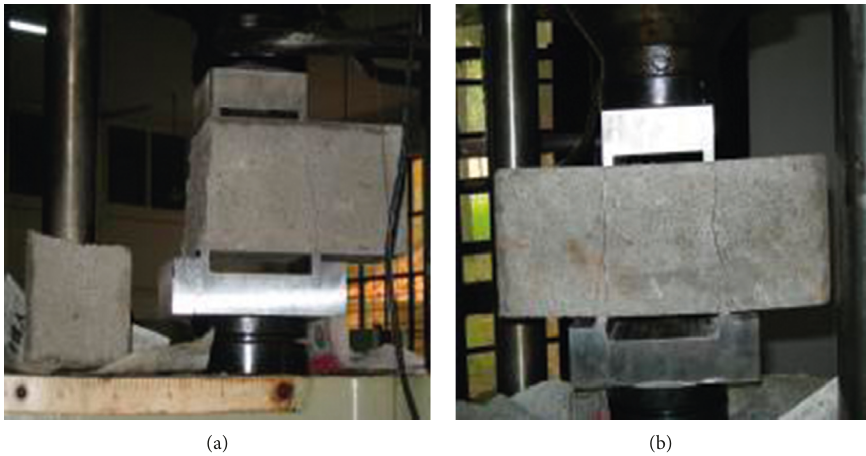
Figure 4: Shear failure true thickness. (a) Reference concrete. (b) Steel fiber-silica fume